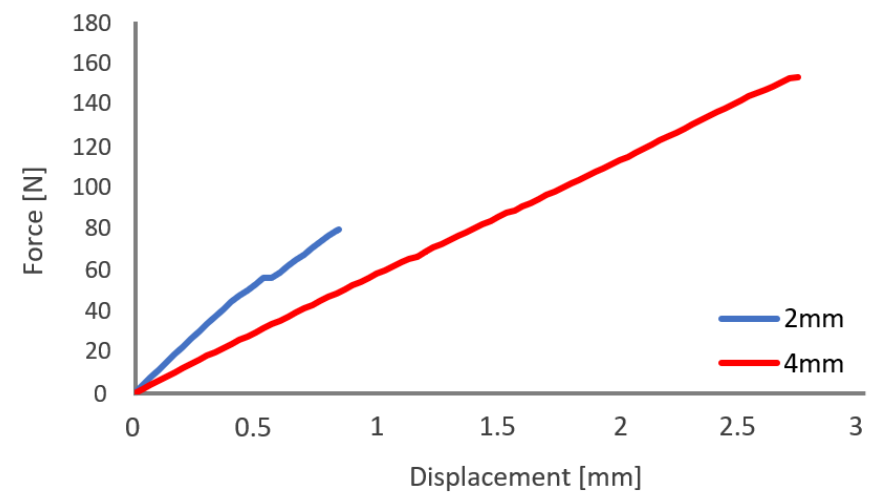
Figure 7. Force-displacement curve for the shear test.